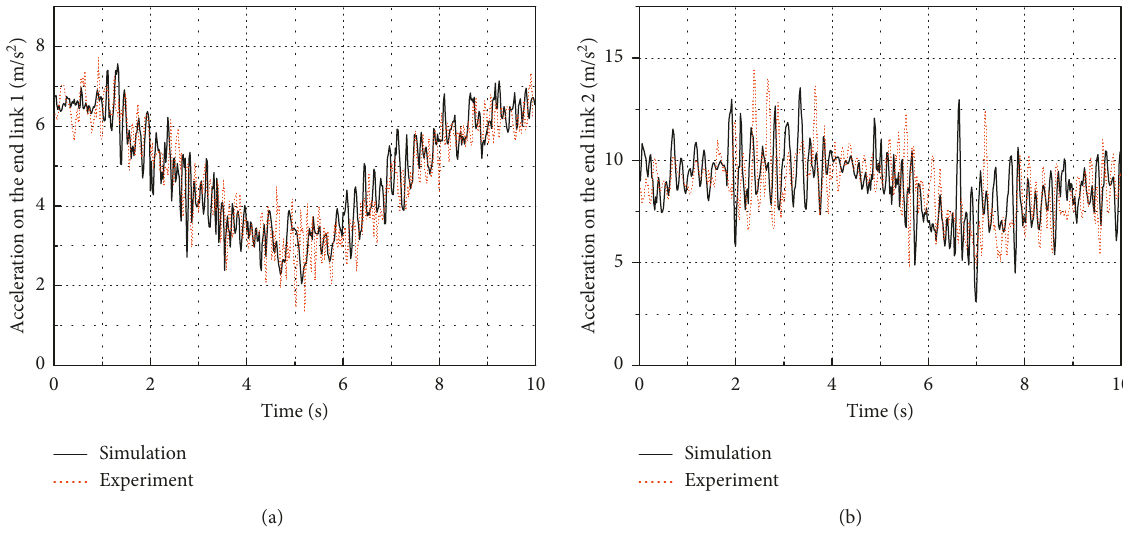
Figure 14: (a) Acceleration of tip of link 1. (b) Acceleration of tip of link